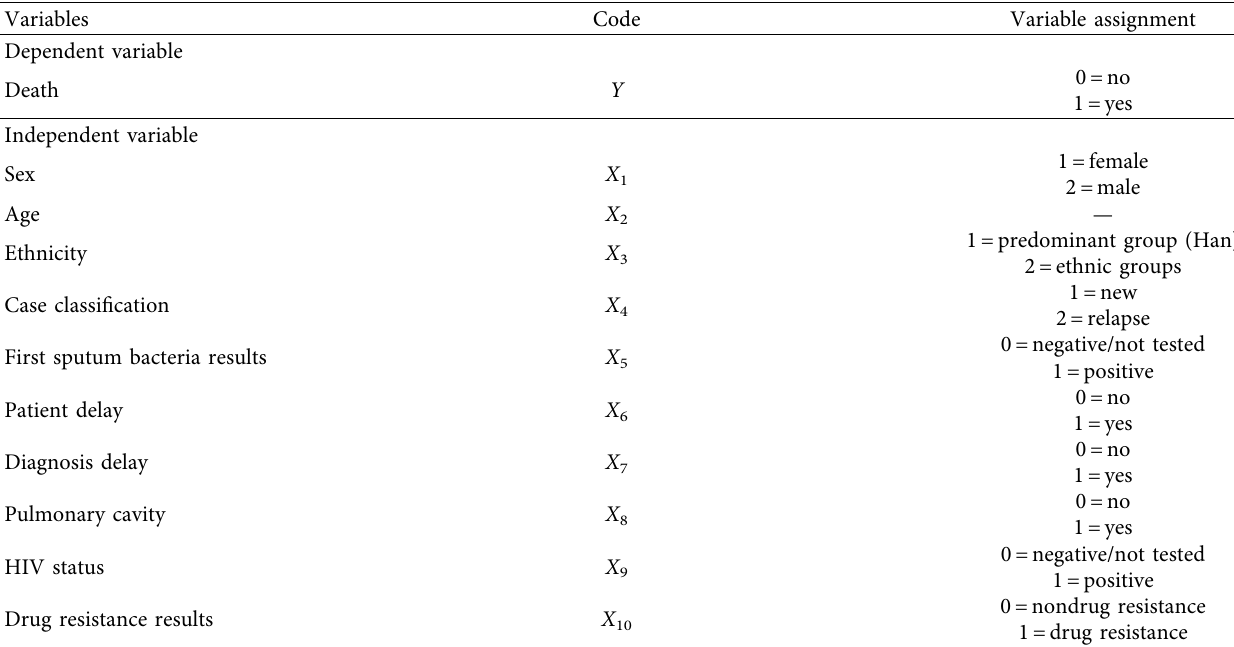
Table 2: Variable assignment table of logistic stepwise regression